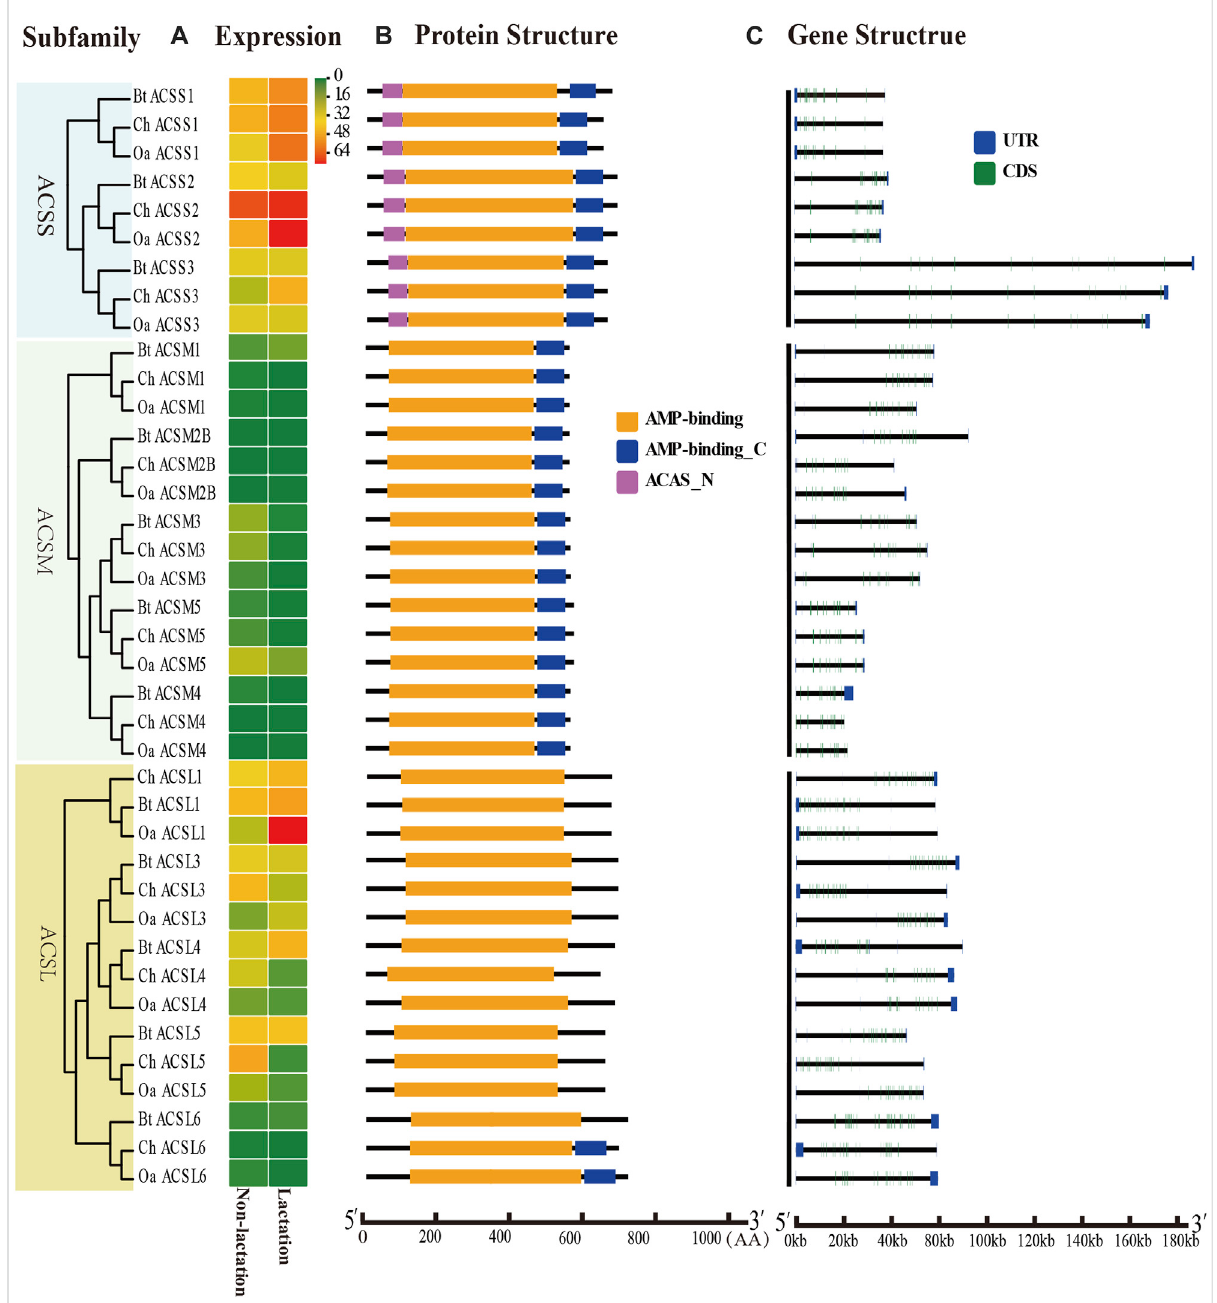
FIGURE 2 Expression pro fi les, gene structure and protein structure of ACS genes from the ACSS, ACSM, and ACSL subfamilies. Legends: (A) Heatmap showing the expression pro fi les of ACS genes in the non-lactation and lactation period of three species (dairy goat, sheep, and cow). Color gradient fromgreen-to-redindicatesexpressionvalueschangefromlowtohigh. (B) StructuresofACSproteinswiththeAMP-bindingdomainrepresentedby orange boxes, the AMP_C domain in red and ACAS_N domain in purple boxes. (C) Structure of ACS genes with exons in green, UTR regions in blue, and solid lines between the colored boxes representing